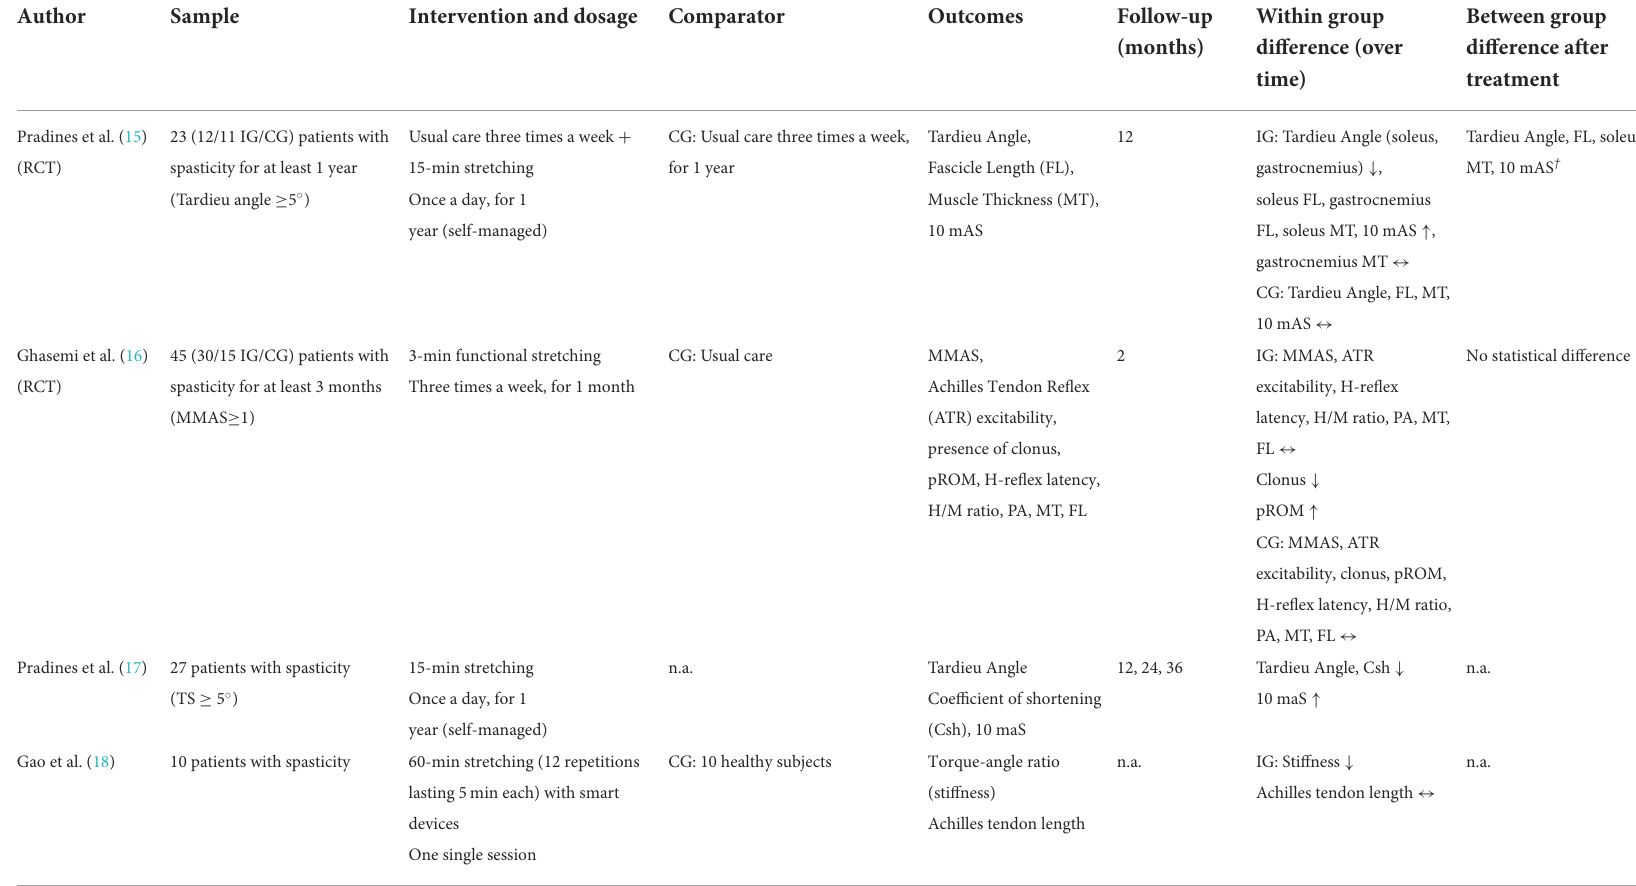
TABLE 1 Characteristics of studies using stretching for the treatment of triceps spasticity after